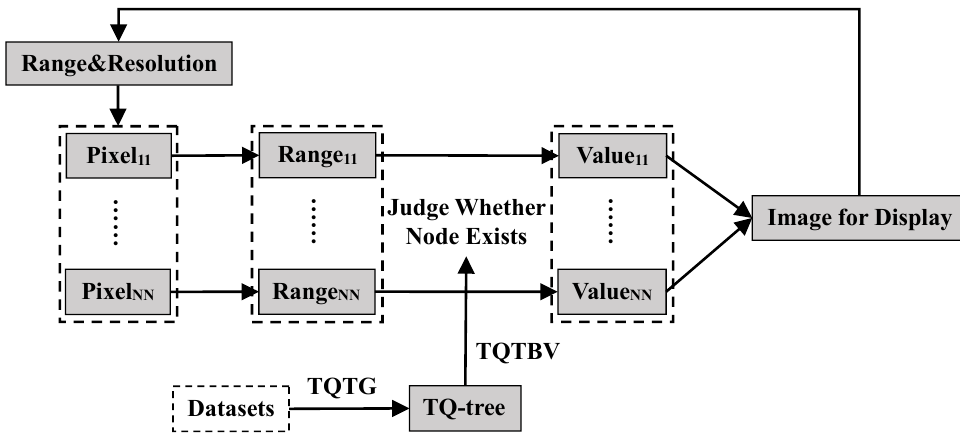
Figure 2. Data pre-processing and visualization flow in